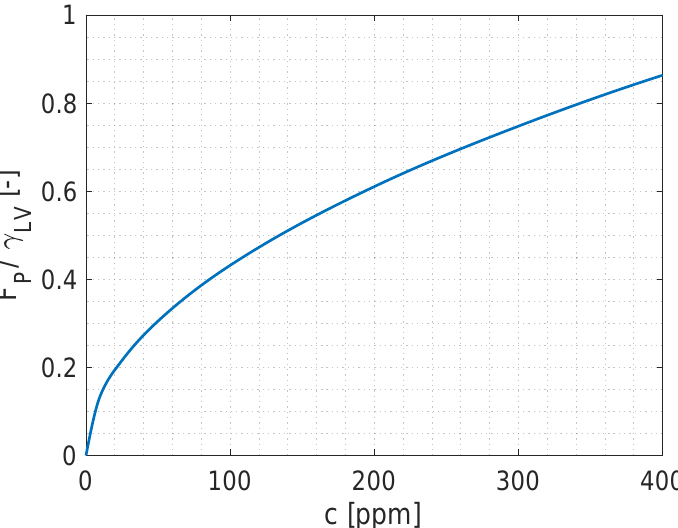
Figure 6. Average polymer stretching force per unit length (Equation (7)), normalized with respect to the surface tension of the solution ( γ LV ≈ 70 mN/m [2,19]), plotted as a function of the polymer mass